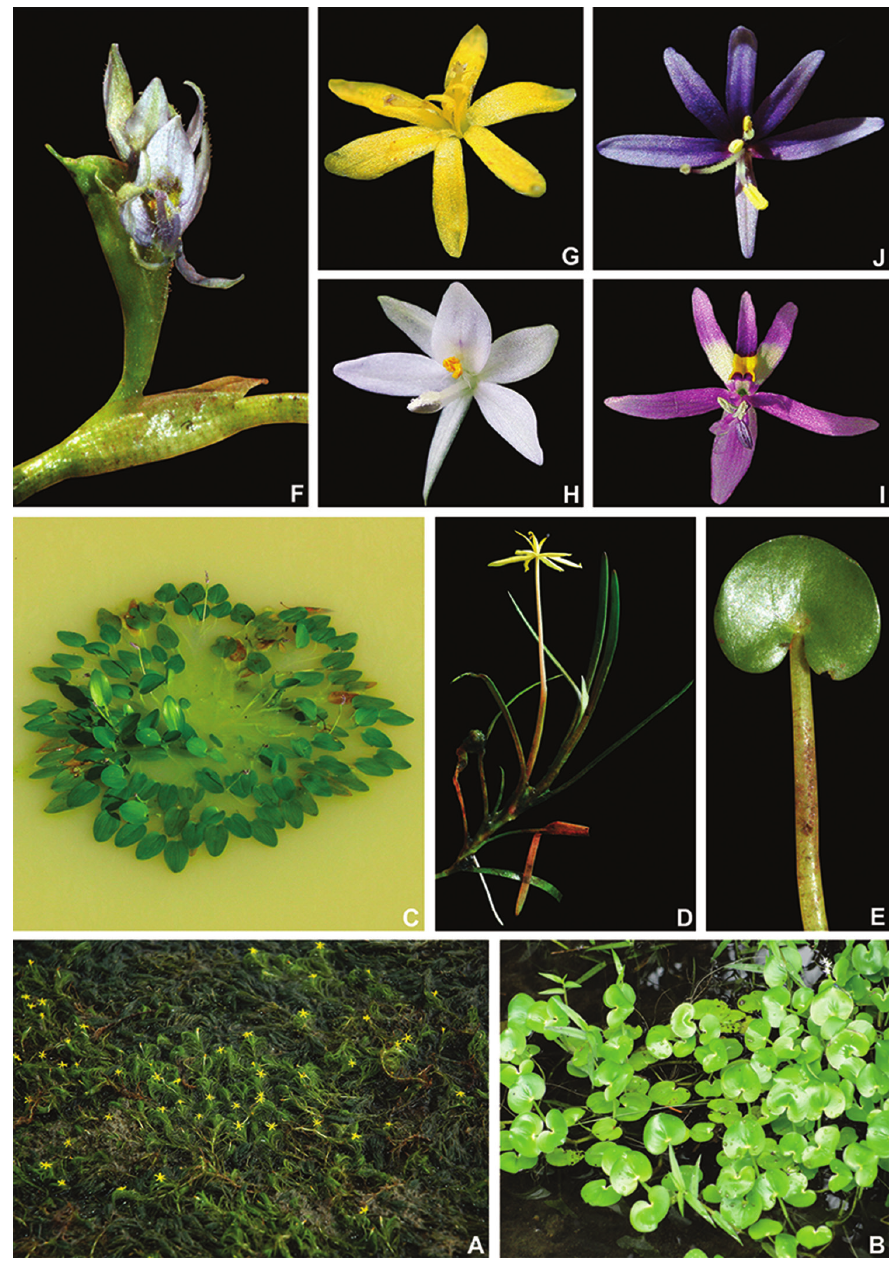
Figure 4. Heteranthera Ruiz & Pav. A–D habit: A emerged and flowering population of H. gardneri (Hook.f.) M.Pell. during the dry season B floating specimen of H. reniformis Ruiz & Pav. C emergent habit with floating and emerged leaves of H. rotundifolia (Kunth) Griseb. D habit of H. dubia (Jacq.) MacMill., showing the persistent sessile leaves E petiolate leaf of H. pumila M.Pell. & C.N.Horn, show- ing the lack of a pulvinus F Ligule and inflorescence of H. pumila G–J flowers: G pseudanthium of H. gardneri H H. reniformis I H. rotundifolia J H. zosterifolia Mart. A by A.P. Fontana B, H by C.N. Horn C, I by A. Popovkin D by S.R. Turner E, F by M.O.O. Pellegrini G by C.P. Bove and J by S.S.